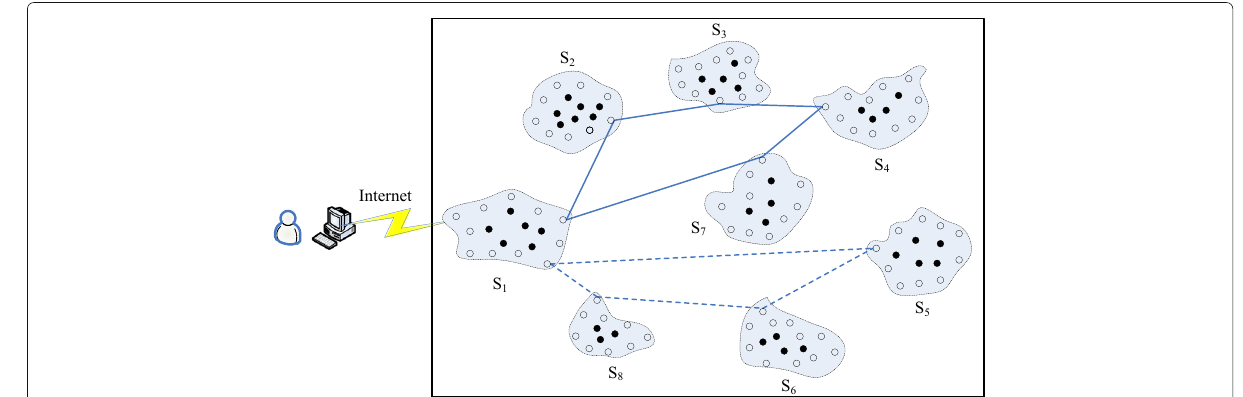
Fig. 1 Principle of connectivity restoring from disjointed WSN by MDCs